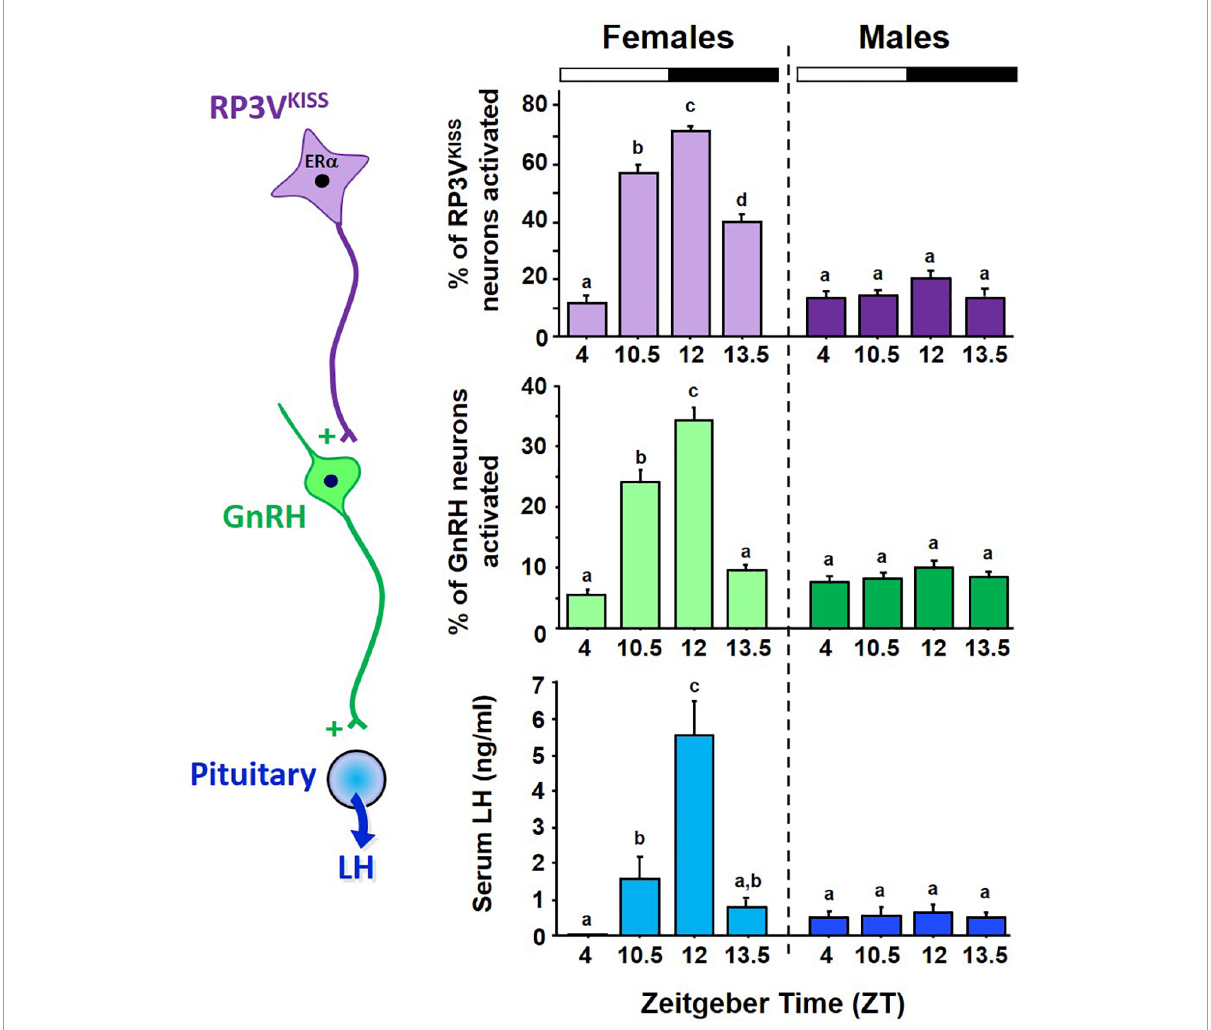
FIGURE3 Circadian changes in RP3V KISS and GnRH neuron activation, measured by cfos induction using double ISH, and serum LH in female mice housed in 12:12 LD cycle. All females were OVX + E 2 . The onset and peak of neuron activation occurs in synchrony with the rise and peak of LH levels indicative of LH surges. For comparison, male littermates were housed in same 12:12 conditions and similarly GDX + E 2 , yet showed no circadian increases in RP3V KISS neuron activation, GnRH neuron activation, or serum LH levels. Bars with different letters above them are significantly different from each other. Adapted from Poling et al.